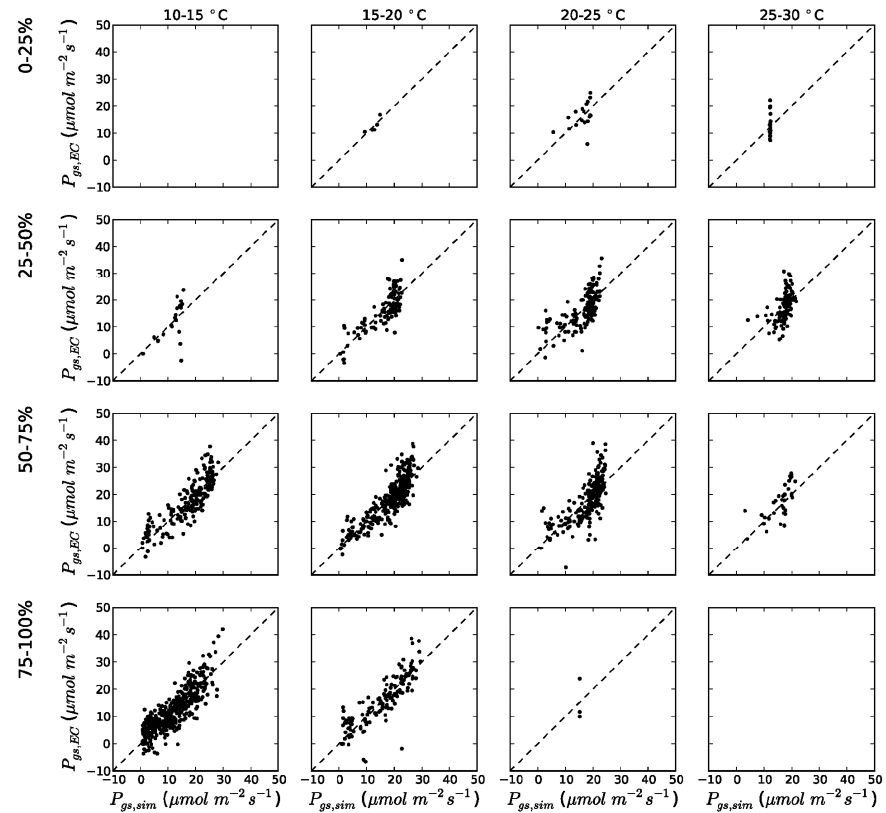
Figure 6. A stratification of the data points shown in Figure 5 into temperature and relative humidity classes.